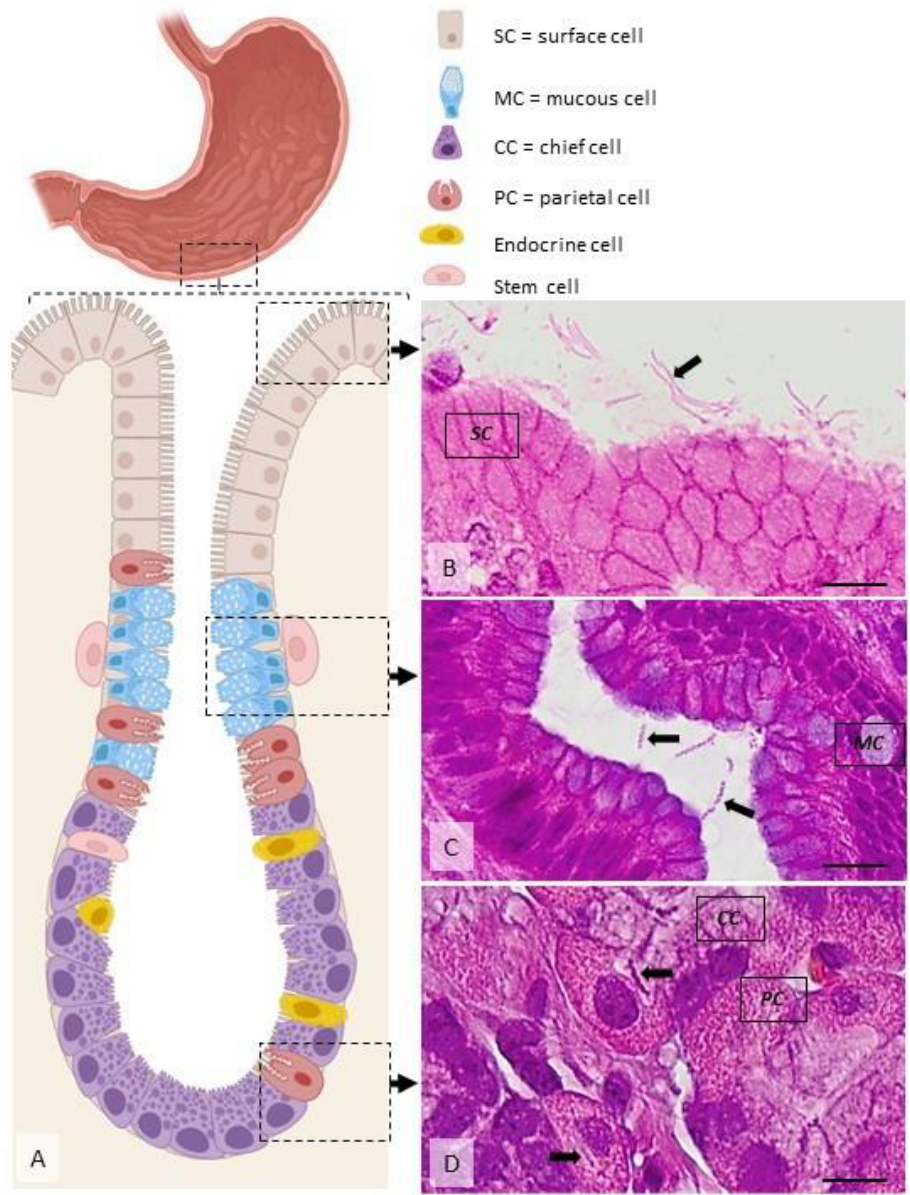
Figure 3. Distribution of H. pylori in the gastric mucosa. ( A ) Diagram showing the main cell types present within the gastric mucosa. Helicobacter spp. are located extracellularly, within the mucus covering the superficial mucosa (( B ), arrow), within the glandular lumen (( C ), arrows), or, rarely, intracellularly, in specific vacuoles (( D ), arrows). Dog, H&E stain, Ob × 100; scale bar = 10 µm. Created using BioRender.